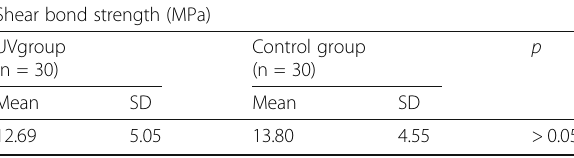
Table 2 Shear bond strength (MPa) for both groups: mean, standard deviation (SD) and independent t test ( P ) Shear bond strength (MPa)